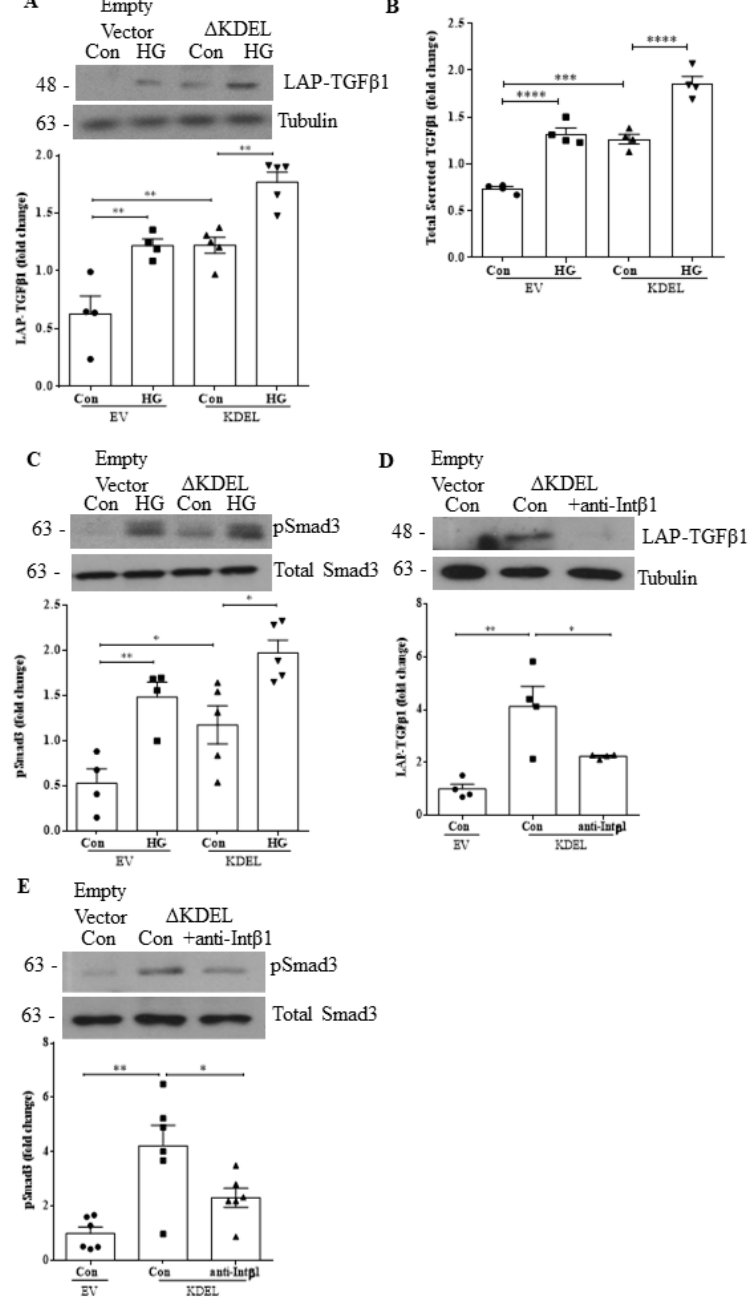
Figure 5. Overexpression of csGRP78 augments TGF β 1 synthesis, secretion, and downstream profibrotic signaling. ( A ) Overexpression of GRP78 Δ KDEL, which increases csGRP78, increased basal LAP-TGF β 1 expression and augmented expression induced by HG (48 h) ( n = 5, ** p < 0.01). Increased basal and HG (48 h)-induced expression of both ( B ) total secreted TGF β 1 ( n = 4) and ( C ) downstream signaling measured by Smad3 phosphorylation (Ser473/475) ( n = 5) were also seen (* p < 0.05, ** p < 0.01, *** p < 0.005, **** p < 0.0001). GRP78 Δ KDEL-induced increases in ( D ) LAP-TGF β 1 and (E) pSmad3 (phosphorylation at Ser473/475) were both attenuated by a neutralizing integrin β 1 antibody (10 µg, HG 48 h, n = 6, * p < 0.05, ** p < 0.01).